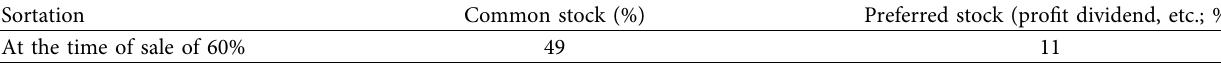
Table 8: Full sale (bidding) scenario.